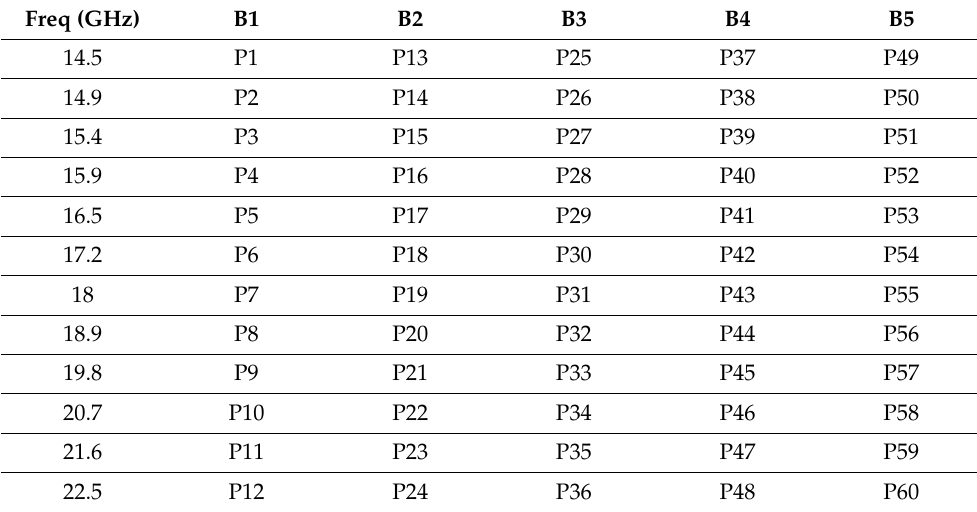
Table 2. The frequency and input beam ports numbers of 60 patterns.